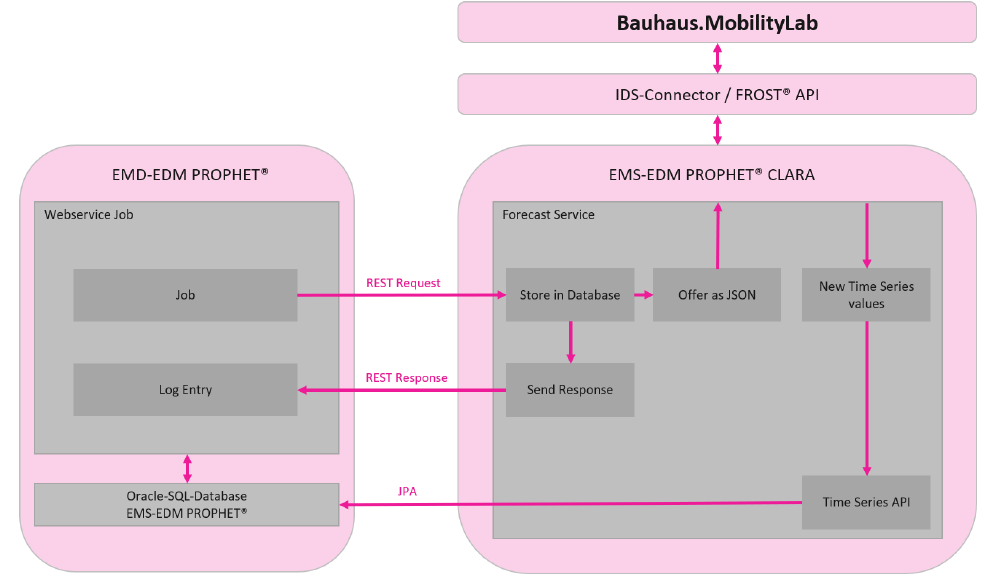
Figure 3. Architecture of the forecast